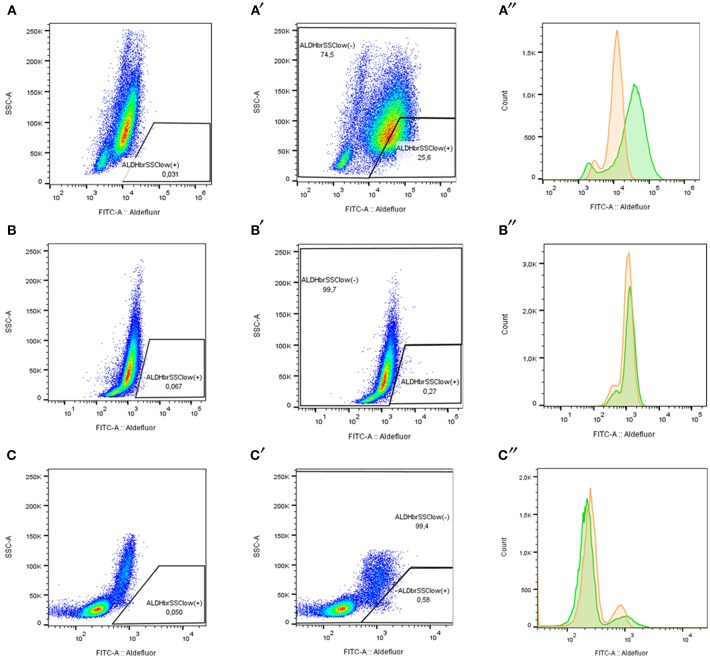
ALDH pattern determination according to ALDH expression in acute leukemia samples stained with ALDEFLUOR reagent. (A–C) ALDHbrightSSClow (+) cells percentage with Aldefluor inhibitor (DEAB+). (A′-C″). ALDHbrightSSClow (+) cells and ALDHbrightSSClow (-) cell percentage without inhibitor (DEAB-). (A″-C″) FITC fluorescence distribution determines ALDH activity in human samples. DEAB+ (orange) and DEAB- (green). (A–A″) LPZ6 (ALDH-numerous). (B–B″) LPZ12 (ALDH-rare). (C–C″) Non-leukemic cells from a healthy donor (negative control).